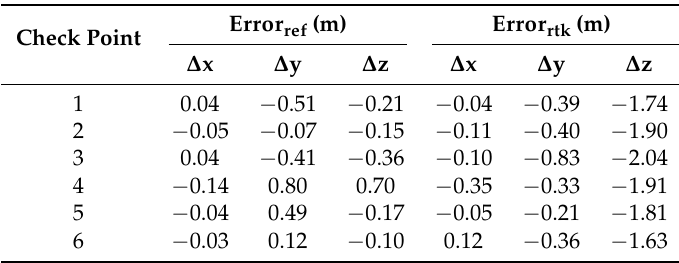
Table 9. Errors of the coordinates of check points compared to RTK GNSS measurements and the coordinates looked up in the aerial orthophoto and DSM: Eichenau dataset.